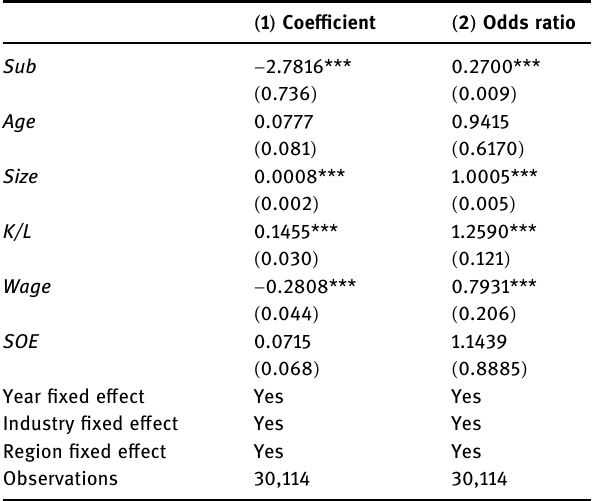
Table 15: Impact of fi scal subsidies on the probability of resurrec - tion of zombie fi rms ( based on matched samples